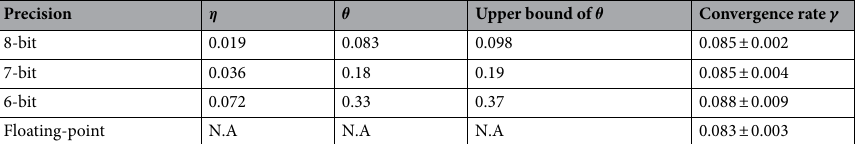
Table 2. Asymptotic errors and convergence rates of the 8-bit, 7-bit, 6-bit, and floating-point iterations. A 95% confidence bound is used in exponential